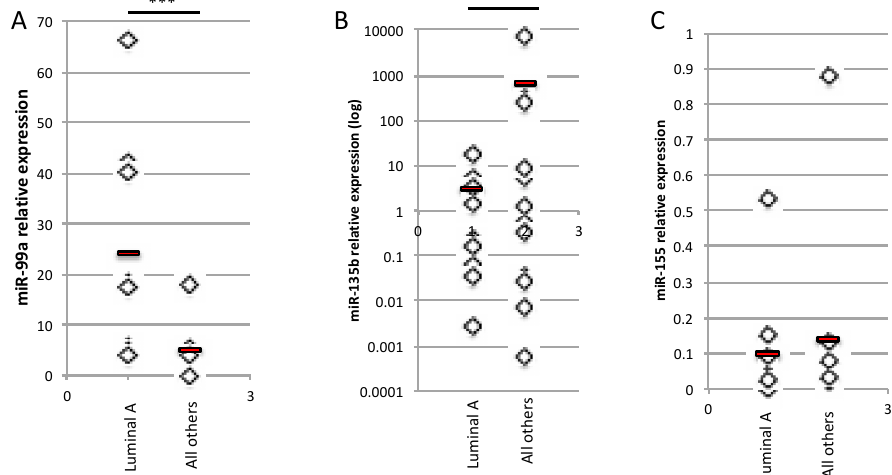
(Figure 5B,C, respectively).